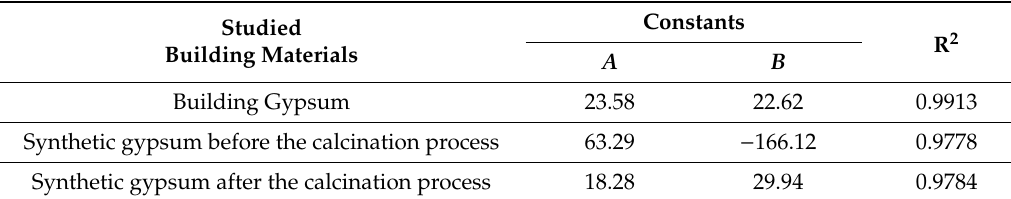
Table 7. A and B constants of equation (10).